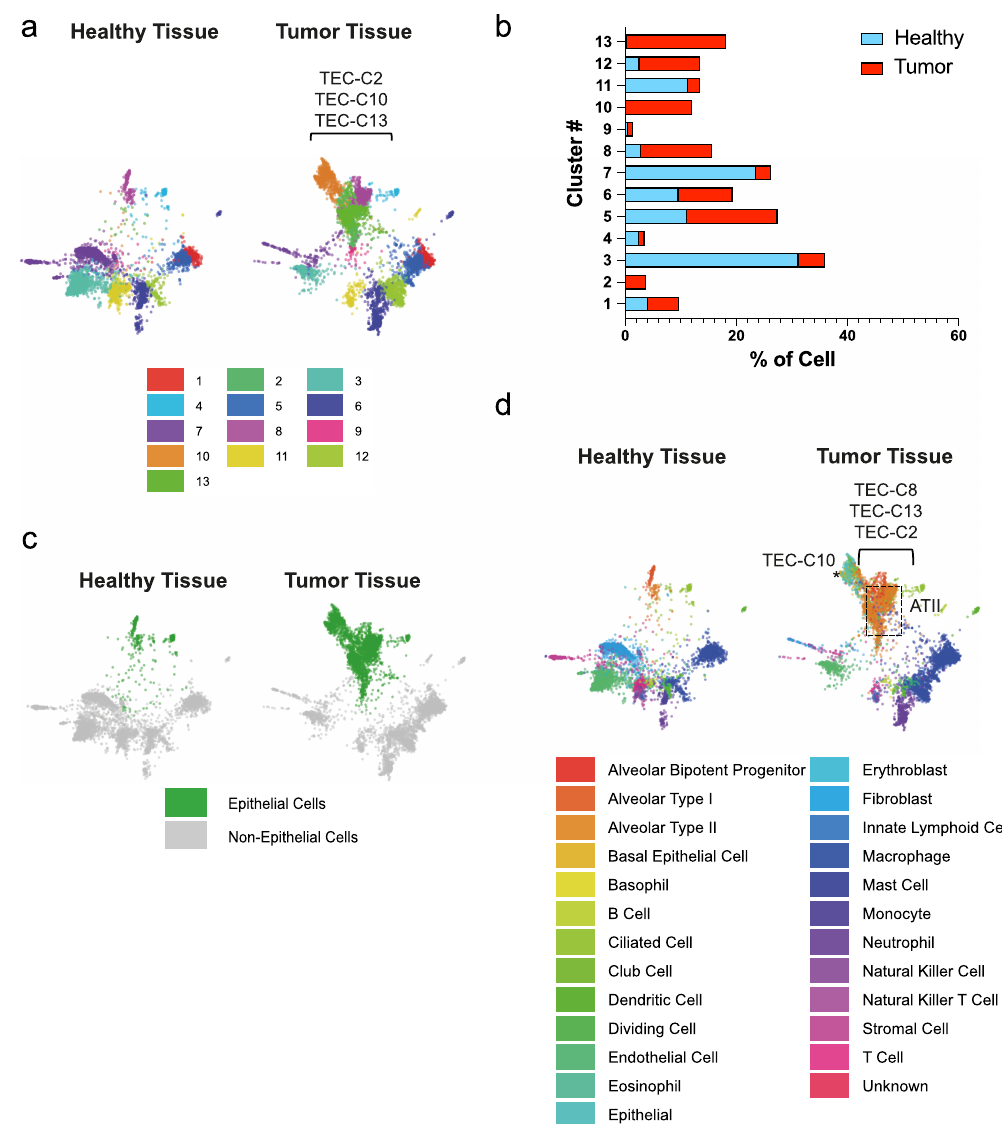
Fig. 2 Single-cell RNA sequencing of healthy and tumor-bearing lungs highlights the presence of a transformed epithelial tumor-speci fi c cluster. a SPRING plots of the 13 clusters identi fi ed in healthy ( n = 2, left panel) and tumor tissues ( n = 3, right panel). b Percentages of clusters distributions in healthy (blue) and tumor (red) tissues. c SPRING plots showing the epithelial compartment (green) in healthy and tumor tissues. d SPRING plots showing the annotated cell types (panel legend) in healthy and tumor tissues. * labels TEC-C10; the dotted boxes highlight ATII-like